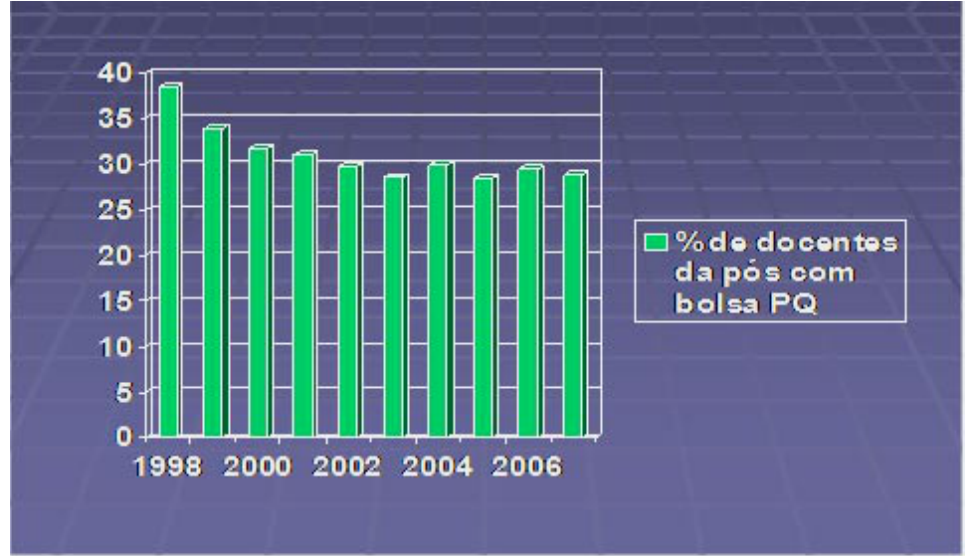
Figura 1 . Percentual de docentes da pós-graduação que receberam bolsas de produtividade em pesquisa a cada ano, entre 1998 e 2007